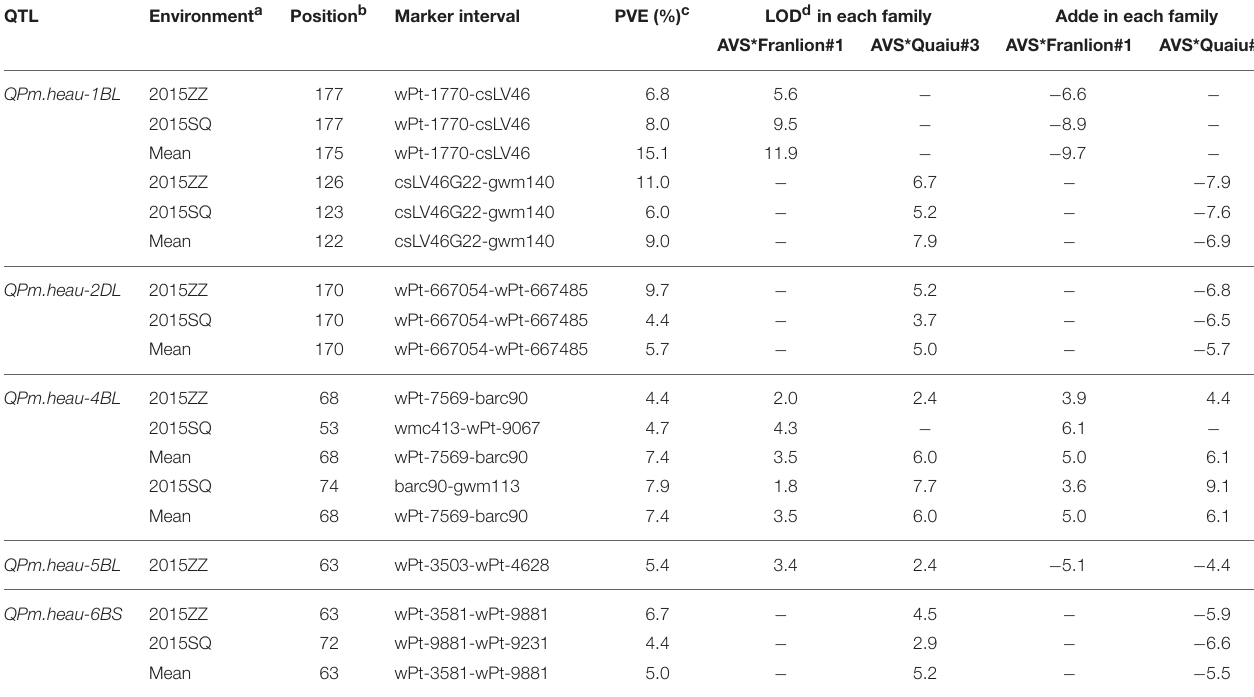
TABLE 3 | Quantitative trait loci (QTL) for adult-plant resistance to powdery mildew detected by joint inclusive composite interval mapping (JICIM) in the two nested association mapping (NAM) populations (Avocet × Francolin#1 and Avocet × Quaiu#3).